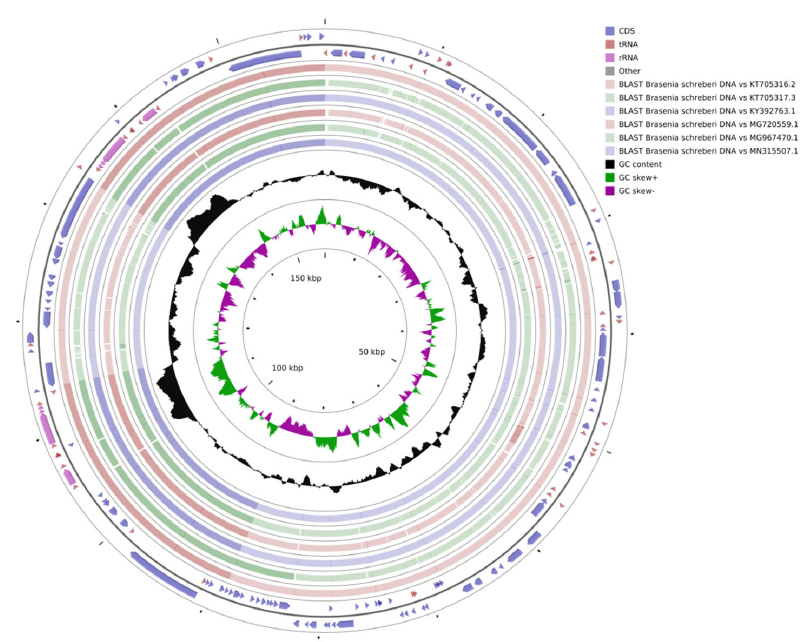
Figure 7. Comparative analysis of chloroplast structure of species from Brasenia and Cabomba of Cabombaceae family. The outer two circles in the figure describe the gene length and direction of the genome, while the inner circles represent the similarity results compared with other reference genomes, and the black circles represent the GC content.